Question: Name the type of graph shown.
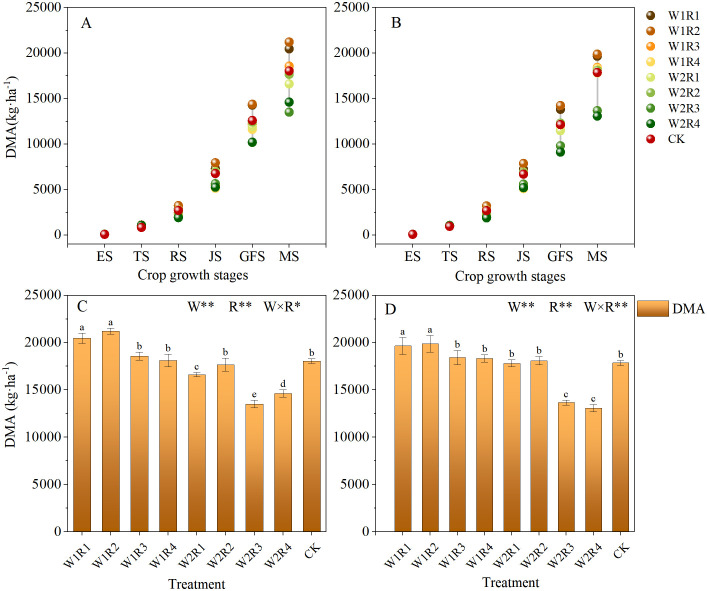
Answer: bar